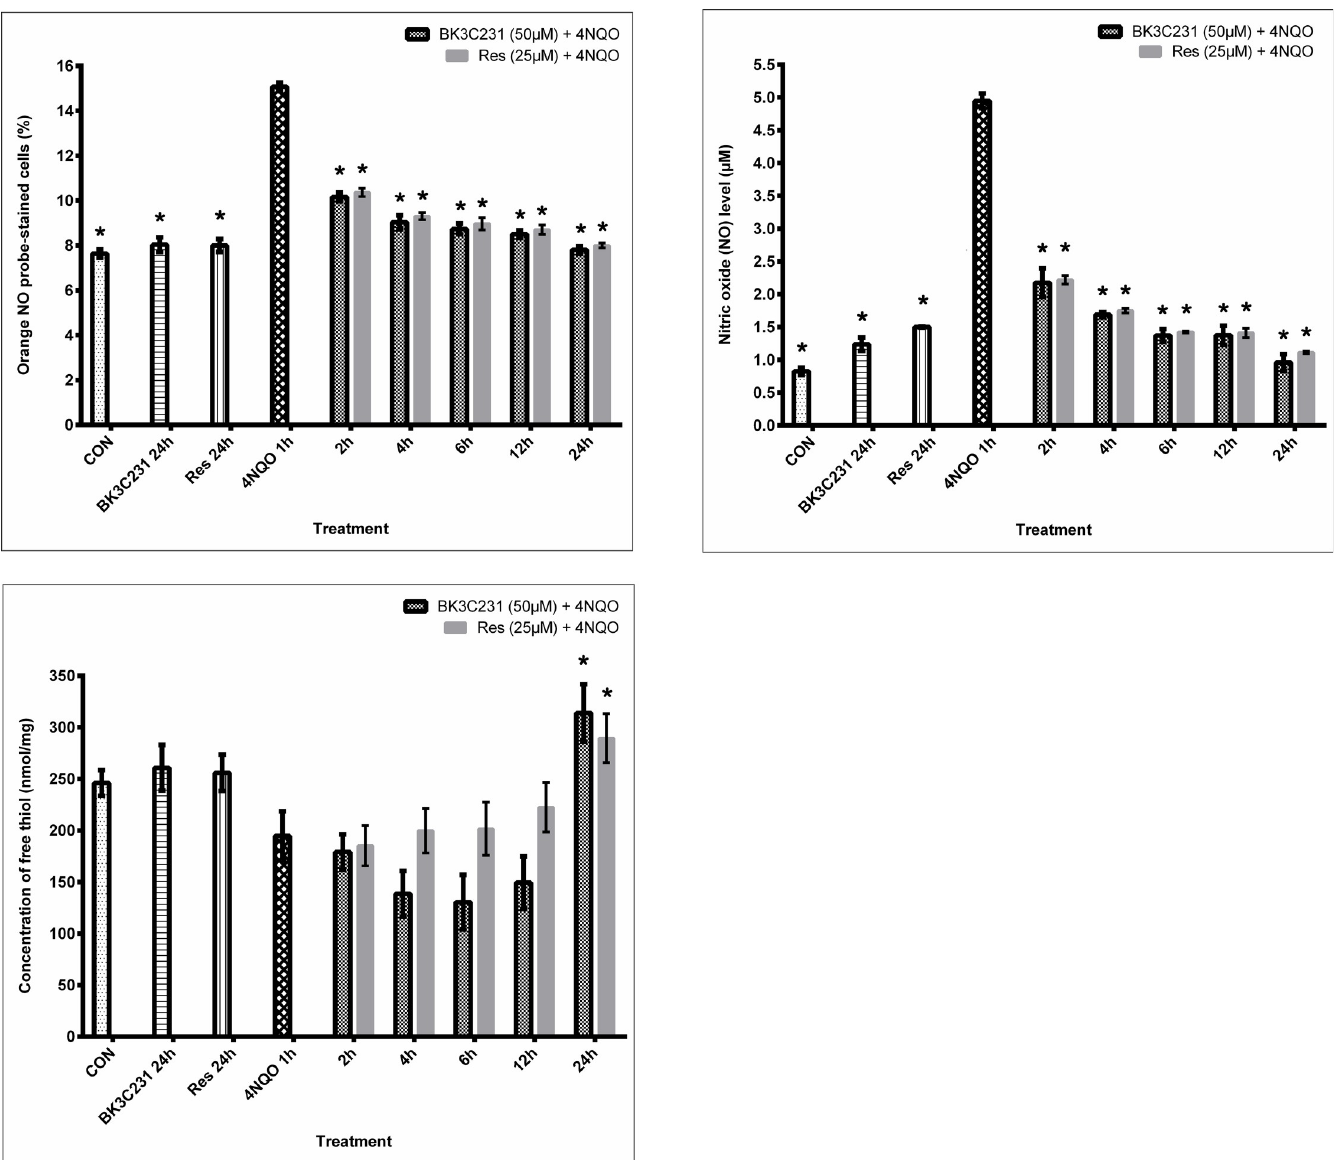
Fig 7. Nitrosative stress assessment in CCD-18Co cells. (A) Determination of intracellular NO level using Orange NO probe staining. (B) Determination of extracellular NO level using Griess assay. (C) Measurement of intracellular GSH level using Ellman’s reagent. Cells were pretreated with BK3C231 at 50 μ M and resveratrol (res) at 25 μ M for 2h, 4h, 6h, 12h and 24h prior to 4NQO induction at 1 μ M for 1h. Each data point was obtained from three independent experimental replicates and expressed as mean ± SEM of orange NO probe-stained cells (%), NO level and concentration of free thiol. � p < 0.05 against positive control, 4NQO